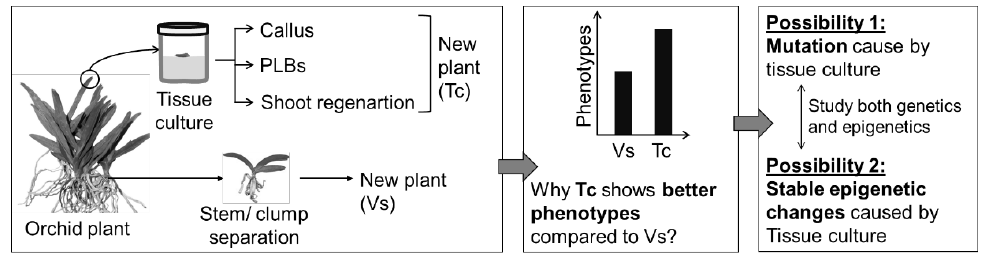
Figure 8. Prospects for advanced molecular research in plant tissue culture using orchid plants as an example. Here, Tc; Tissue culture regenerated plants, Vs; traditional vegetatively propagated plants.